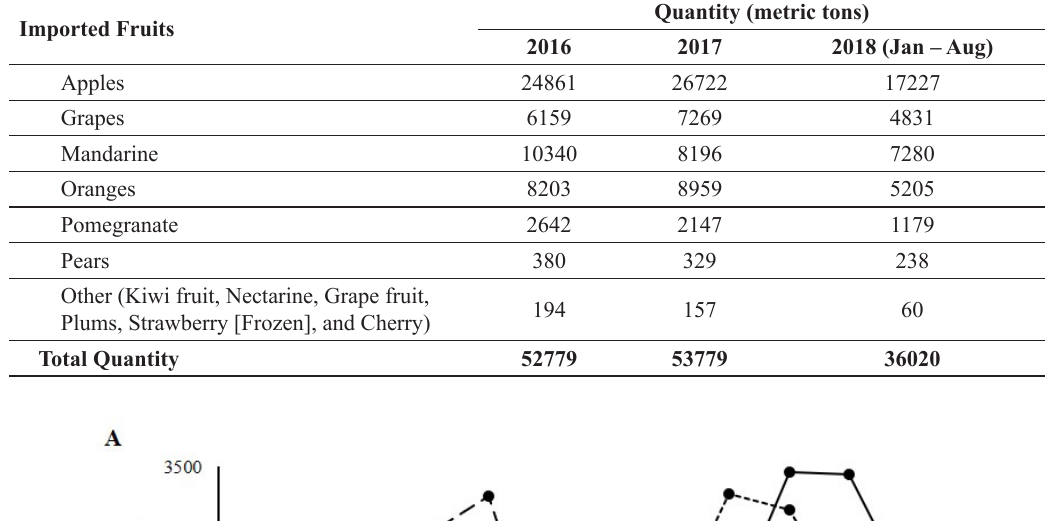
Table 2: The annual import of fruits to Sri Lanka.